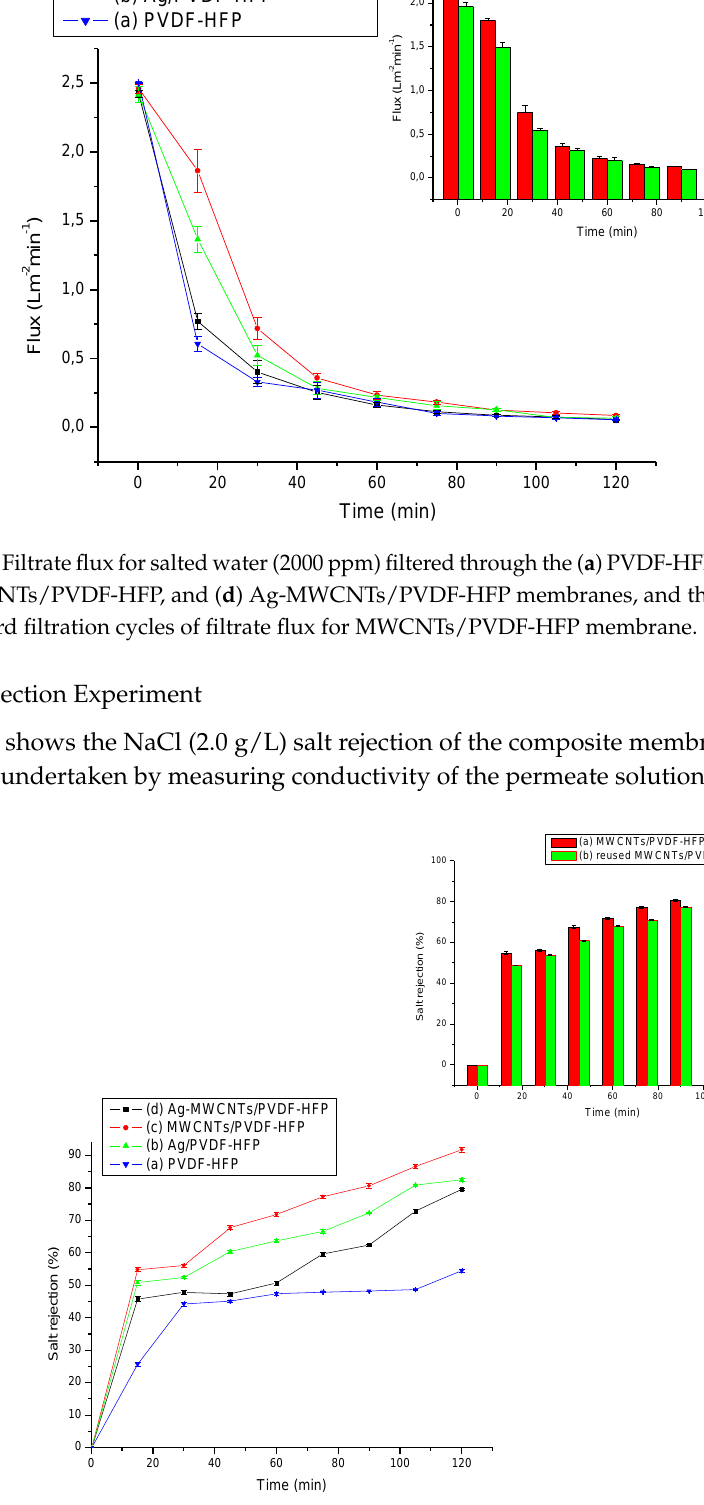
Figure 8. Salt rejection tests of the permeate solution after filtration using ( a ) PVDF-HFP, ( b ) Ag/PVDF-HFP, ( c ) MWCNTs/PVDF-HFP ( d ) Ag-MWCNTs/PVDF-HFP membrane and the insert showing the 1st and 3rd filtration cycles of salt rejection using MWCNTs/PVDF-HFP membrane.